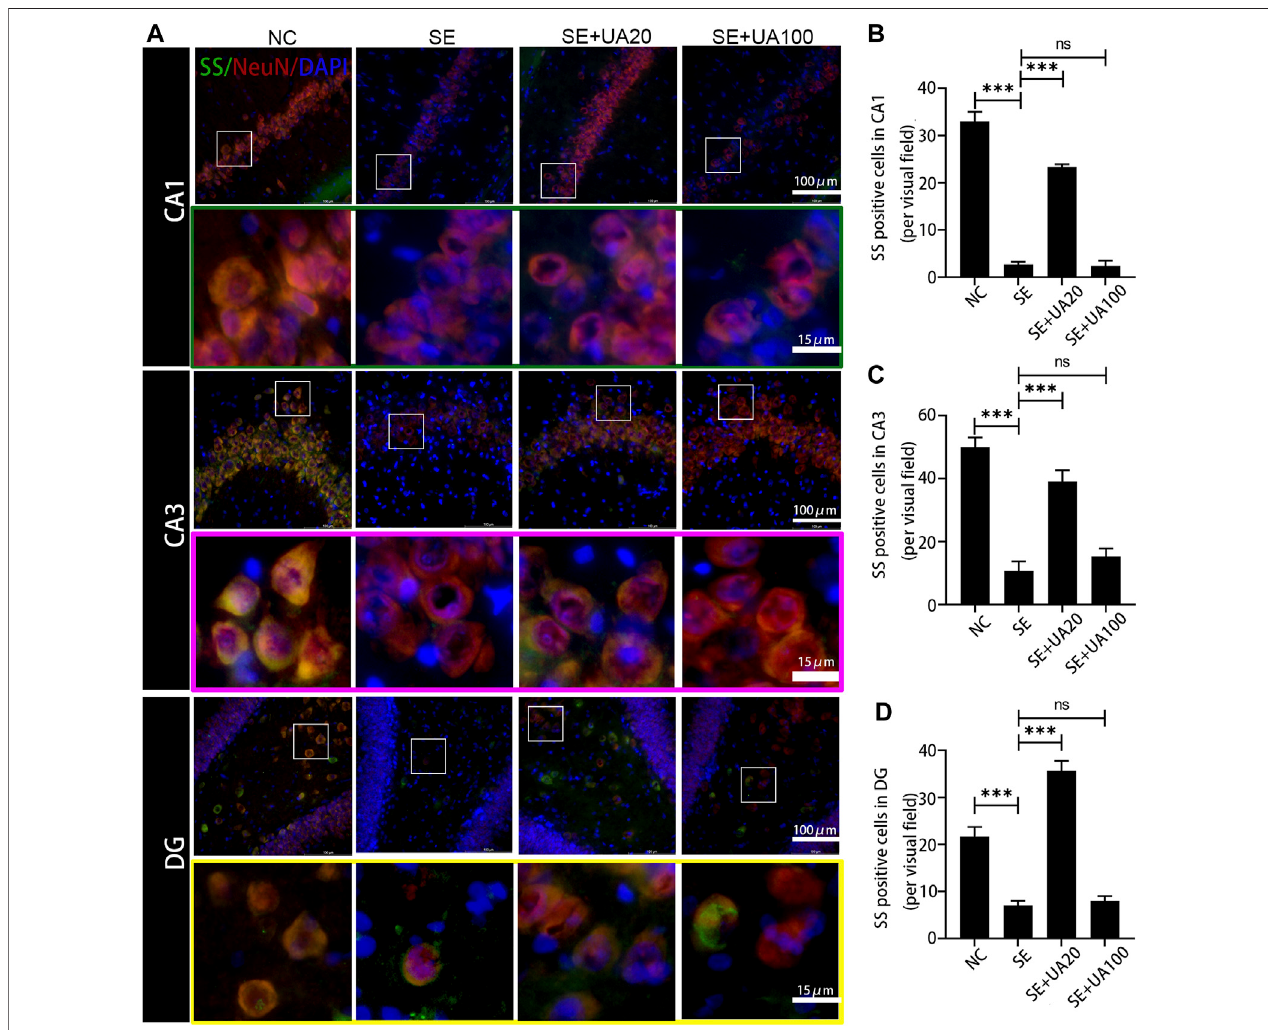
FIGURE 9 | UA promoted the SS expression after SE induction. (A) Immuno fl uorescent triple-staining of SS (green), NeuN (red), and DAPI (blue) in the CA1, CA3, andDGregionsofrathippocampus. (B – D) ThenumberofSS + cellsineachregionofhippocampusafterSEinduction(threeratspergroup,allvalueswereexpressedas means ±SD, ppp p < 0.001, p p < 0.05 vs. SE, one-way